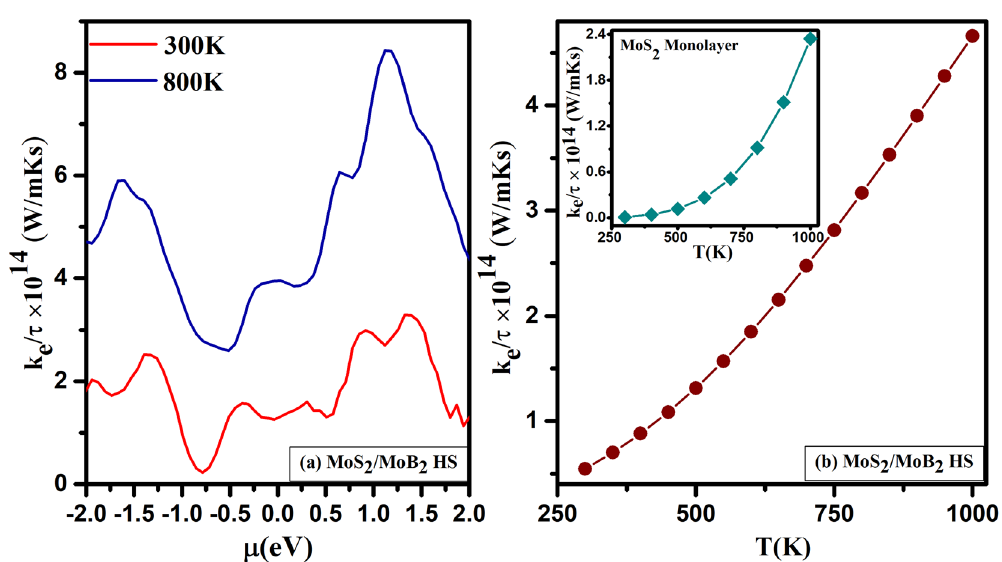
Figure 11. Thermal conductivity as a function of ( a ) chemical potential ( μ ( eV )) and ( b ) Temperature T(K) of MoS 2 / MoB 2 HS and inset of ( b ) Temperature T(K) of MoS 2